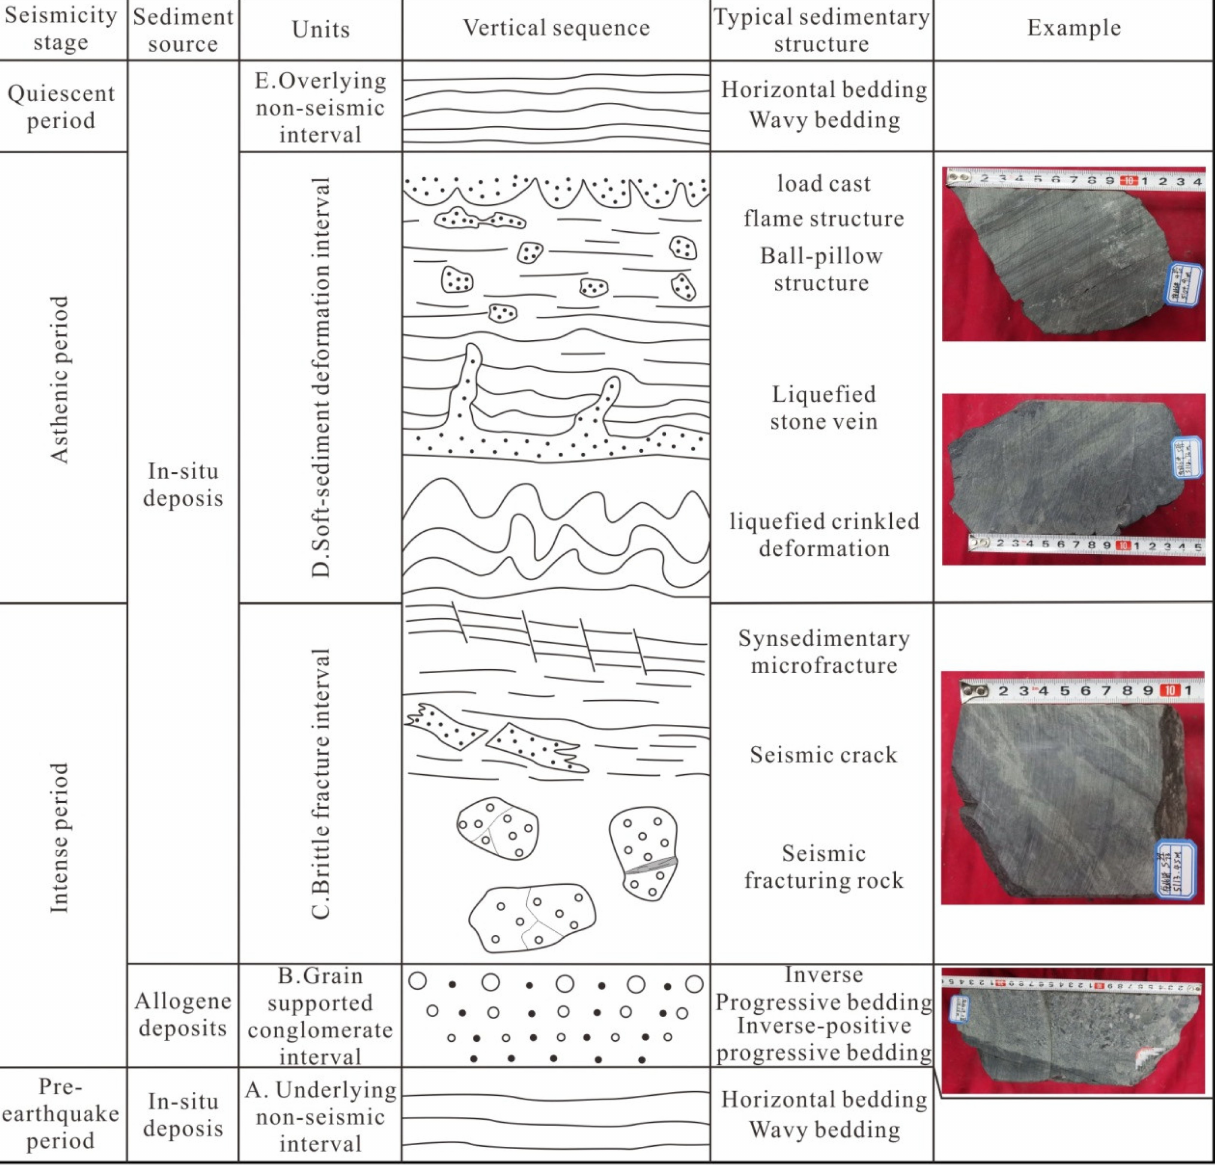
Figure 6. Stratigraphic sequences of seismites in the Carboniferous formation of the Shibei